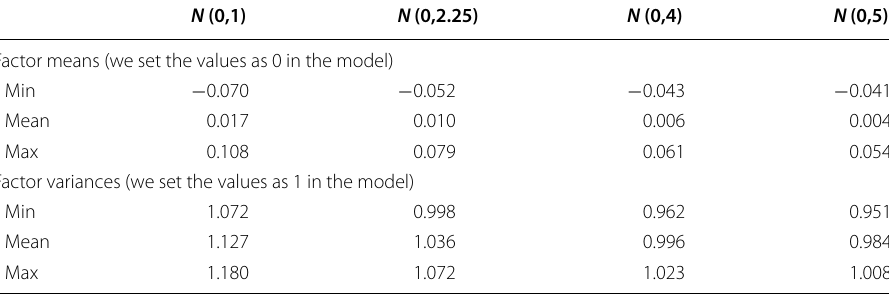
Table 5 Means and variances of plausible values for the factors N (0,1) N (0,2.25) N (0,5) Factor means (we set the values as 0 in the model)